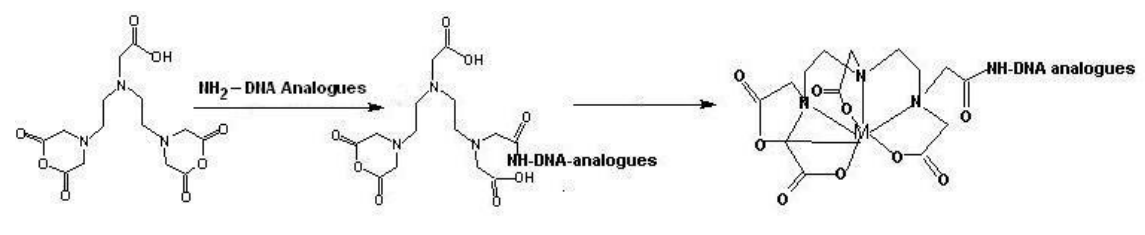
Figure 3. Conjugation of the cyclic DTPA anhydride to amine-derivatized oligomers, and radiolabeling.